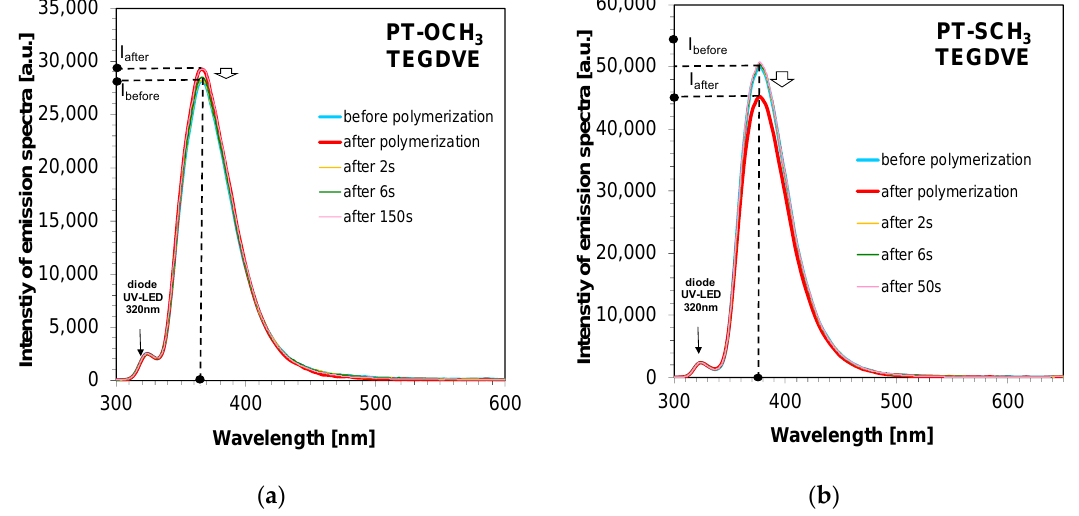
Figure 15. Changes in emission spectra during irradiation at 320 nm of the system containing the TEGDVE monomer without the addition of a HIP photoinitiator and ( a ) the PT-OCH 3 sensor and ( b ) the PT- SCH 3 sensor.